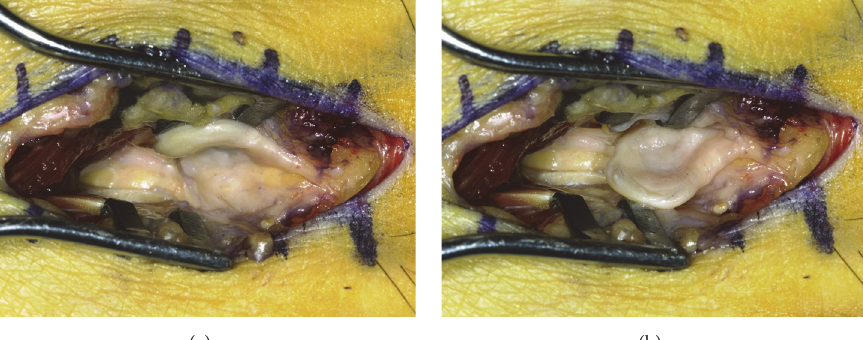
Figure 2: Intraoperative photograph. (a) Dorsally deviated course of the interdigital nerve and neuroma; (b) transversely reclined neuroma showing the impression in its center assumedly made by the adjacent metatarsal heads.